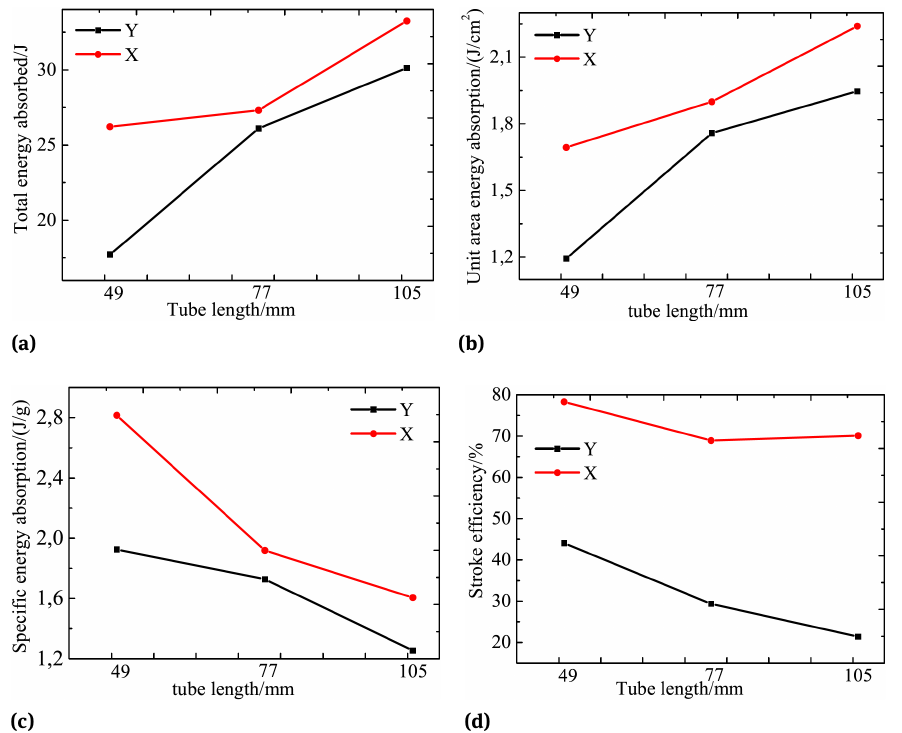
Figure 10: Paper corrugation tubes for different tube lengths: (a) total energy absorbed, (b) unit area energy absorption, (c) specific energy absorption (d) stroke